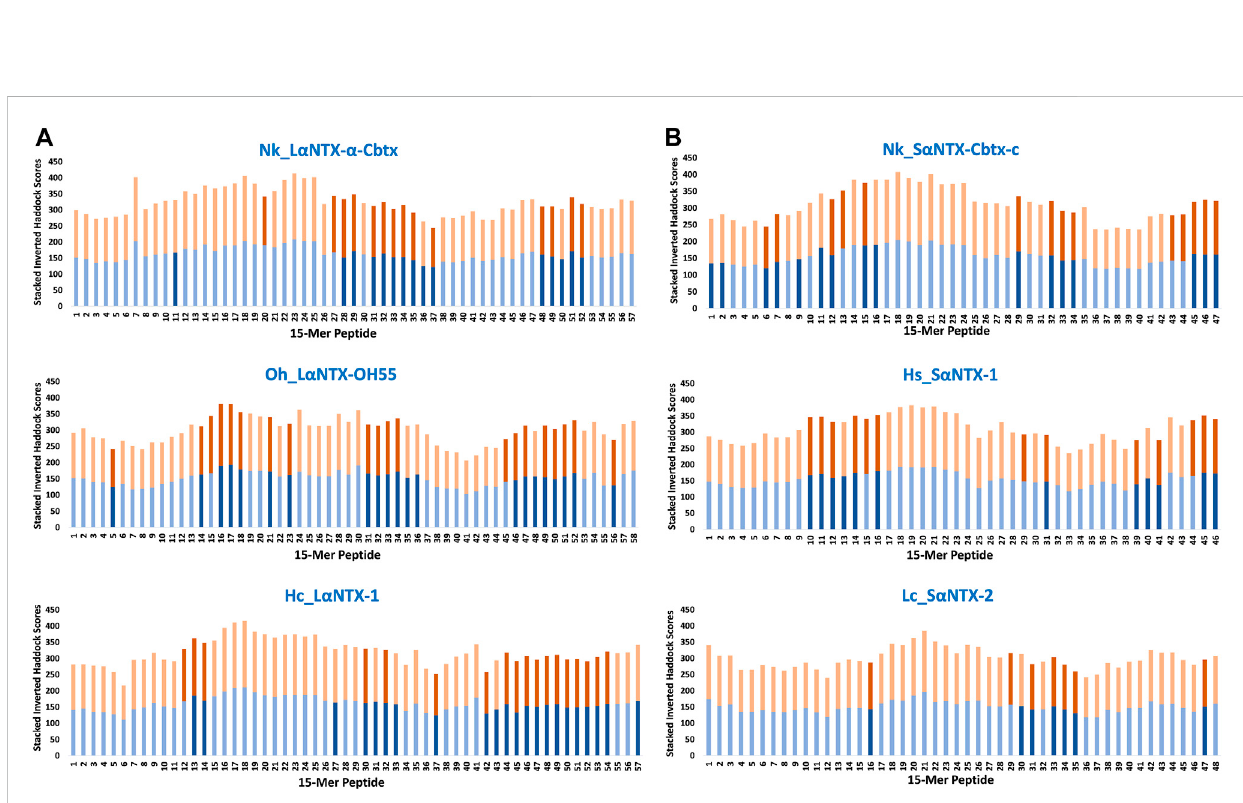
FIGURE 5 Accumulative inverted HADDOCK scores of 15-mer peptides binding decoys (Eqca-DR:15-mer) derived from docking of Eqca-DRA MHCII models to 15-mer peptidesgenerated from α -neurotoxins. (A) Long-chain alpha-neurotoxins(L α NTX),and (B) Short-chainalpha-neurotoxins(S α NTX).Bluebars indicate Eqca-DRA*00103:DRB2*00201; and orange bars indicate Eqca-DRA*00201:DRB2*00201. Bars with dark blue/dark brown indicate the decoys (Eqca:15-mer) that ful fi lled the de fi ned algorithm in the present study. Abbreviations: Nk_L α NTX- α -Cbtx, α -cobratoxin (UniProt ID: P01391, N. kaouthia ); Oh_L α NTX-OH55, long neurotoxin OH55 (UniProt ID: Q53B58, O. hannah ); Hc_L α NTX-1, long neurotoxin 1 (UniProt ID: Q8UW29, H. curtus ); Nk_S α NTX-Cbtx-c, cobrotoxin-c (UniProt: P59276, N. kaouthia ); Hs_S α NTX-1, short neurotoxin 1 (UniProt ID: P68415, H. schistosus ); and Lc_S α NTX-2, short neurotoxin 2 (UniProt ID: P10457, L. colubrina